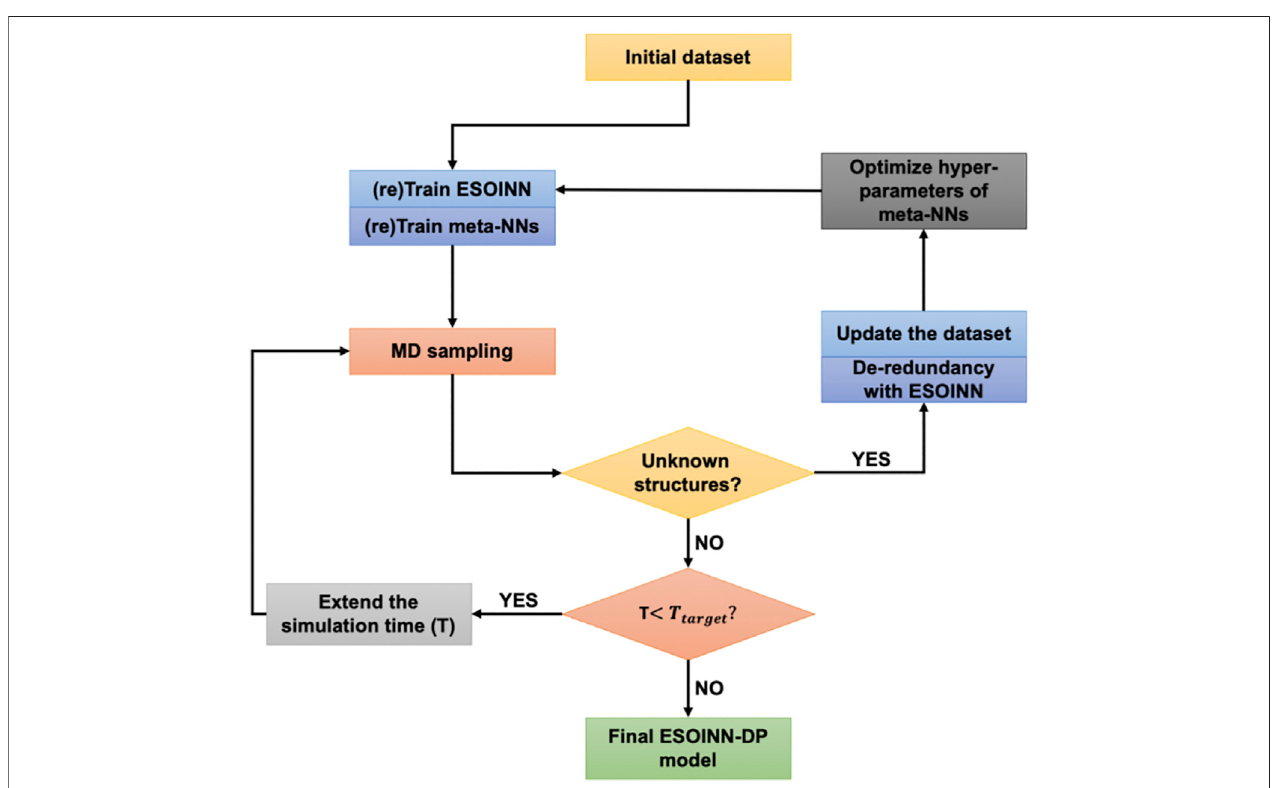
FIGURE 3 | The training process of the NN